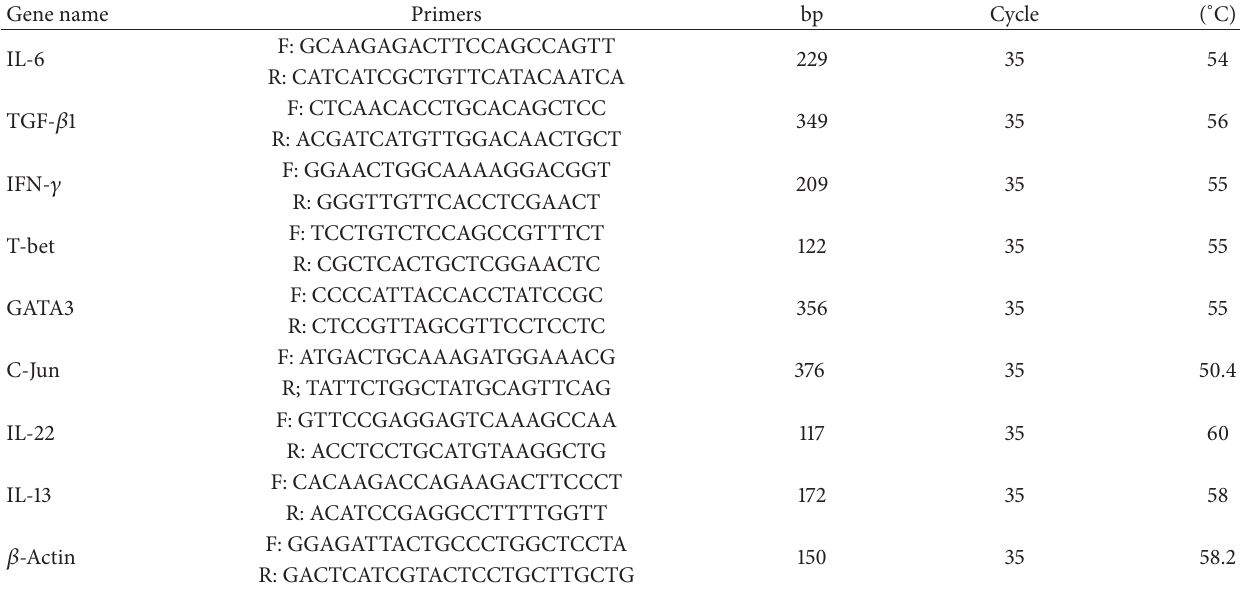
Table 1: Primers for target